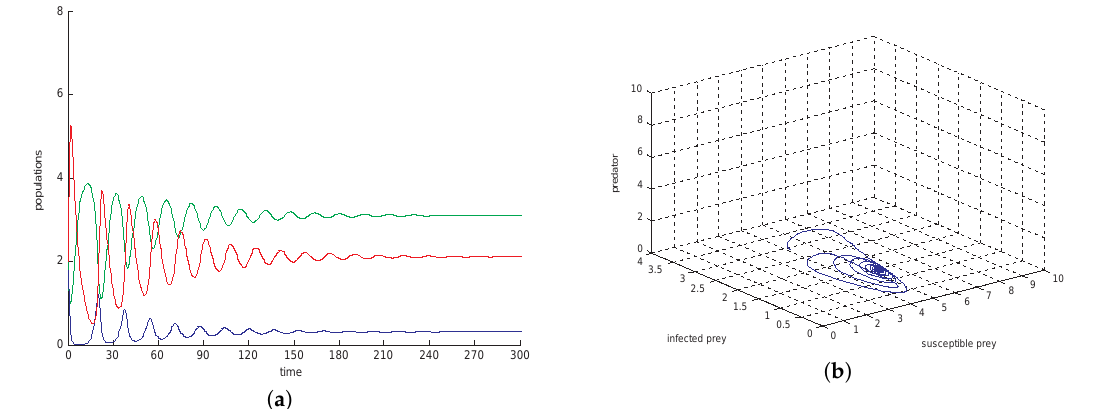
Figure 3. ( a ) time series evolution of the populations of system (1); ( b ) phase-space trajectories corresponding to the stabilities of the population with the parameters a = 1.65, b = 0.3, f = 0.65,